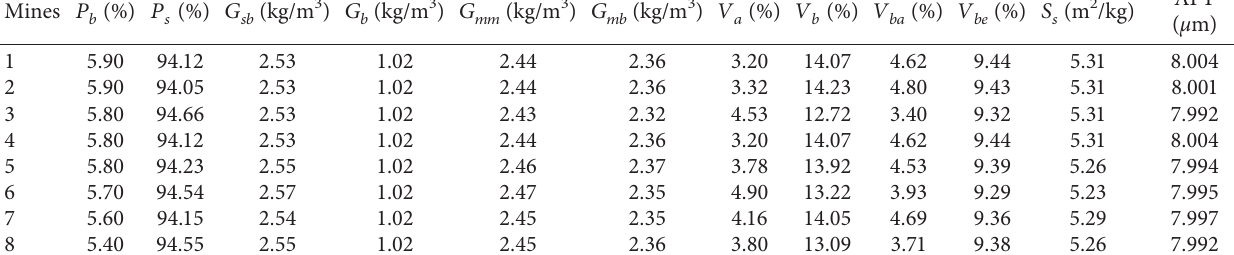
Table 6: Measuring the bitumen apparent film